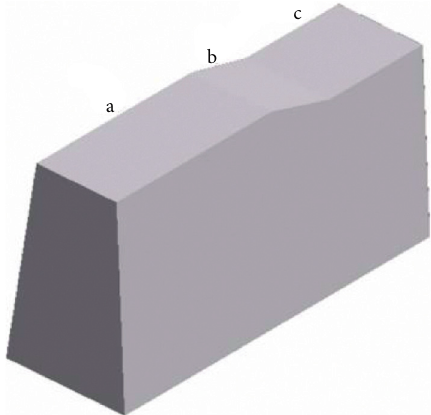
Figure 2: The simplified model of the wall.